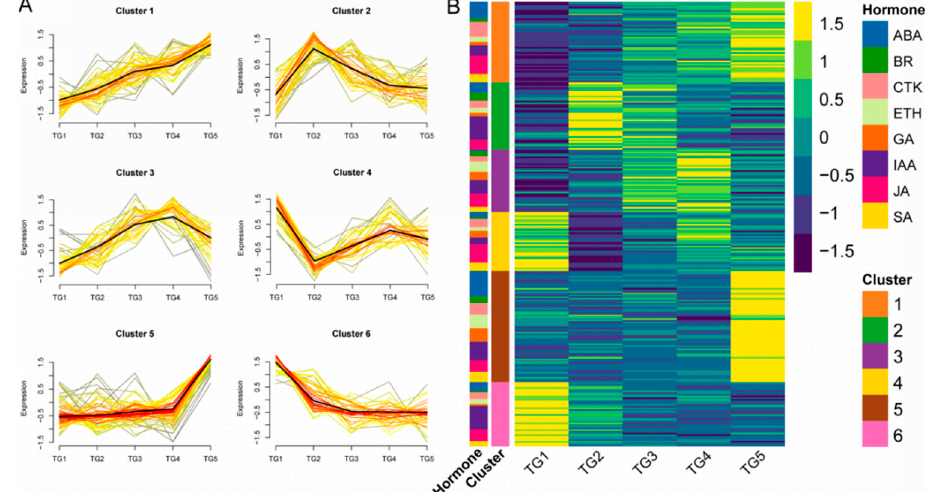
Figure 5. The expression patterns of hormone-associated genes by hierarchical clustering analysis. ( A ) Each square represents a pattern. Each line indicates a gene in this cluster.The color lines indicate the genes that better fit the overall expression trend in this cluster, as indicated by the black line, as they appear darker and closer to the black line. ( B ) Cluster expression heatmap of hormone-associated genes. The annotation on the left side of the heatmap shows the distribution of hormones in each cluster.